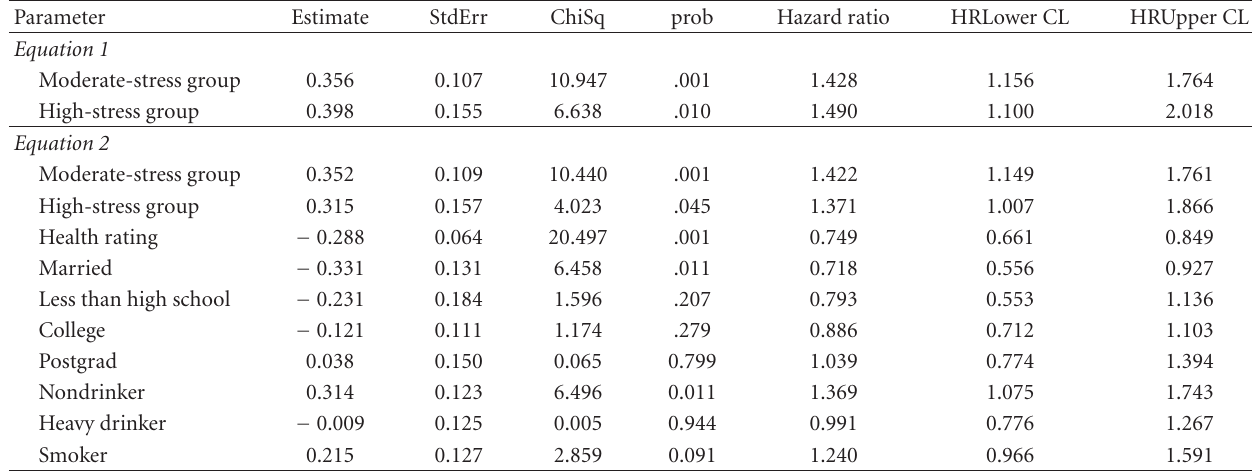
Table 5: Proportional hazard models predicting mortality ( N =